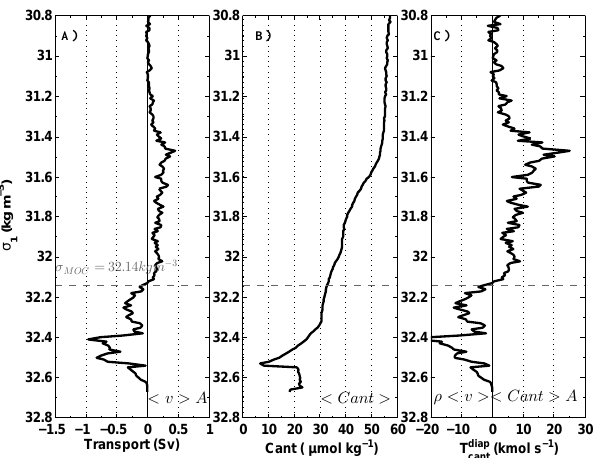
Fig. 5. T diap cant and the different elements by which it was computed (see Eq. 7). (A) Profile of anomalies of volume transport integrated into density ( σ 1 ) layers with a 0.01kgm − 3 resolution. (B) Mean profile of Cant averaged at each density layer. (C) T diap cant profile. All the data represented in this figure are the averages of the six surveys analyzed in this work. In the formulation, A means the area of each density layer along the section and replaces the overbar given in Eq. (7), since there is no vertical integration in the data displayed there.